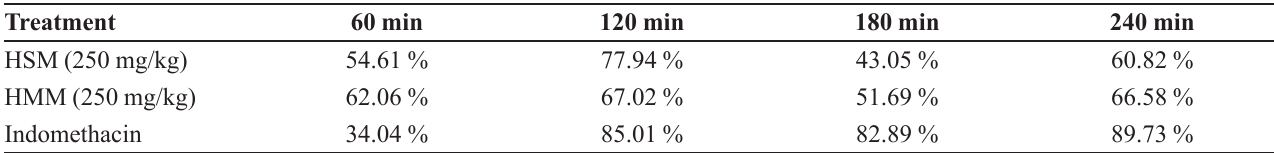
TABLE VI - Results of % inhibition of paw edema in extracts from H. plicatum subsp. plicatum on carrageenan-induced paw edema (n=6) Treatment